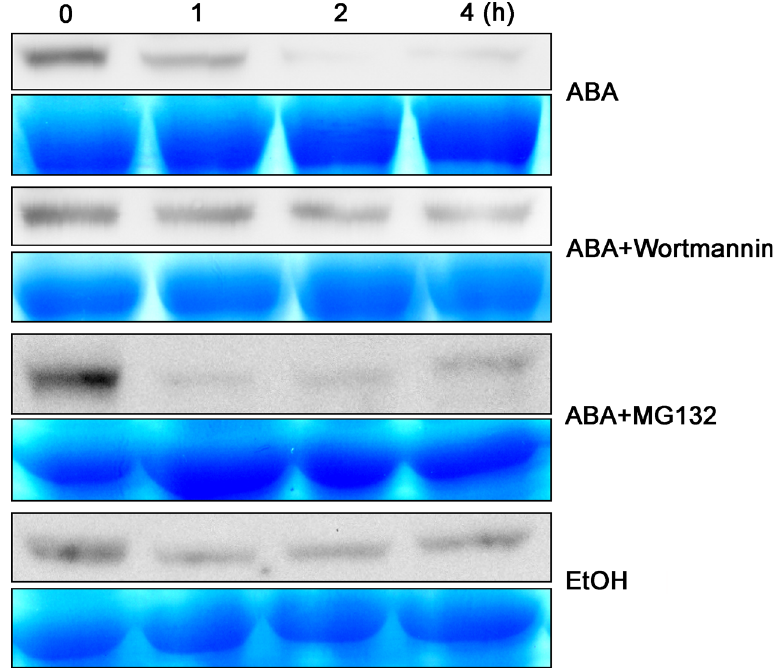
Fig 3. GEF1 protein is degraded in response to ABA treatment. Western blot analyses of GFP-GEF1 protein levels in response to the indicated treatments. Ten-day-old pUBQ-GFP-GEF1 Arabidopsis seedlings were immersed in 1/2 MS liquid medium for 1 h, then transferred into 1/2 MS medium supplemented with 50 μ M ABA or 50 μ M ABA plus 20 μ M Wortmannin, and 0.1% (v/v) EtOH for the indicated durations. For MG132 treatment, seedlings were immersed in 1/2 MS medium with 50 μ M MG132 for 2 h, then transferred in 1/2 MS medium with 50 μ M ABA plus 50 μ M MG132 for the indicated durations. Total protein extracts (20 μ g) were subjected to immunoblot analysis with GFP antibody. Coomassie blue staining of SDS-polyacrylamide gel (SDS-PAGE) was used as a loading